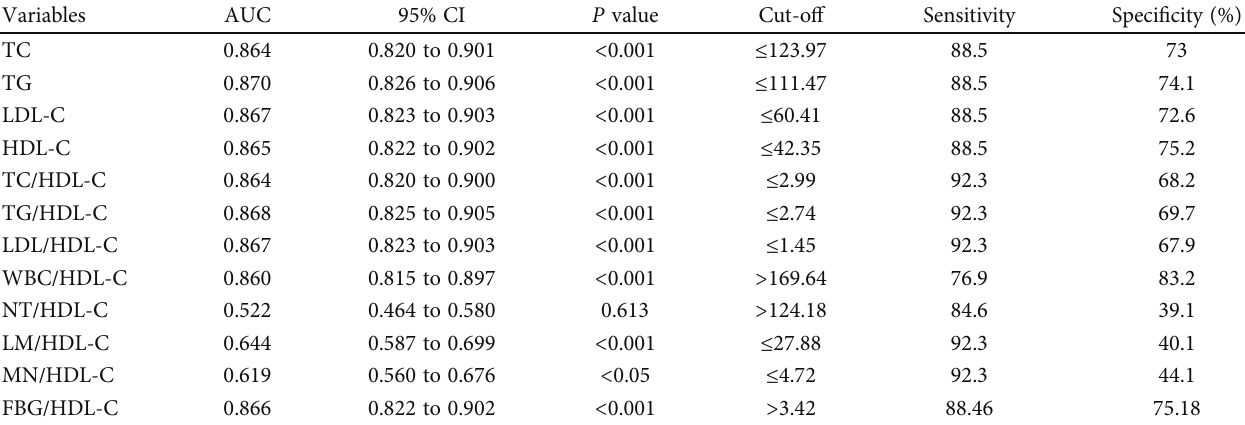
Table 3: Receiver-operating characteristics (ROC) curves and prognostic accuracy of lipid pro fi le and its relative ratios in COVID-19.